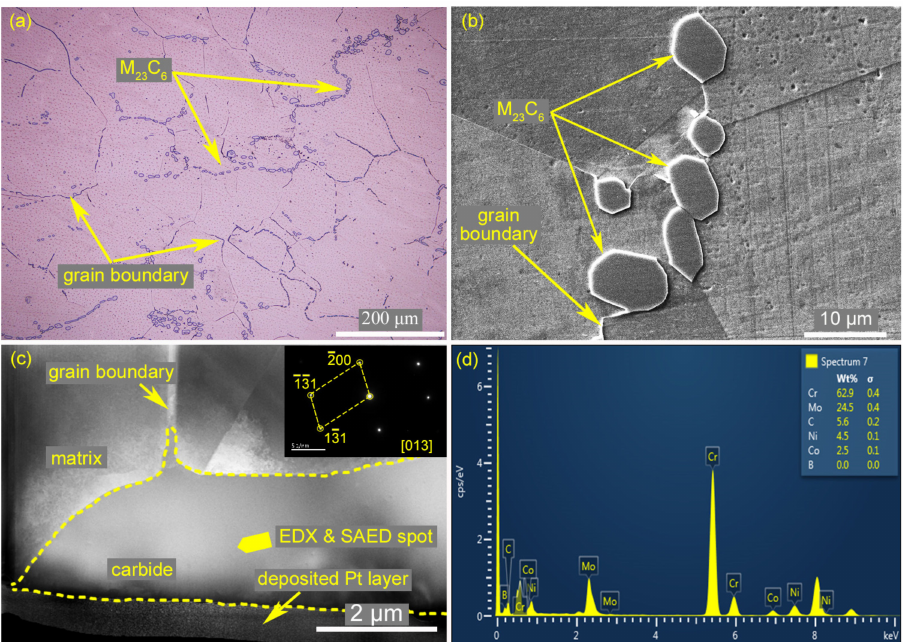
Figure 3. Microstructure of 617B BM under the as-received condition: ( a ) OM, ( b ) SEM, ( c ) TEM, and SAED, ( d ) EDX result of the carbide in ( c ).